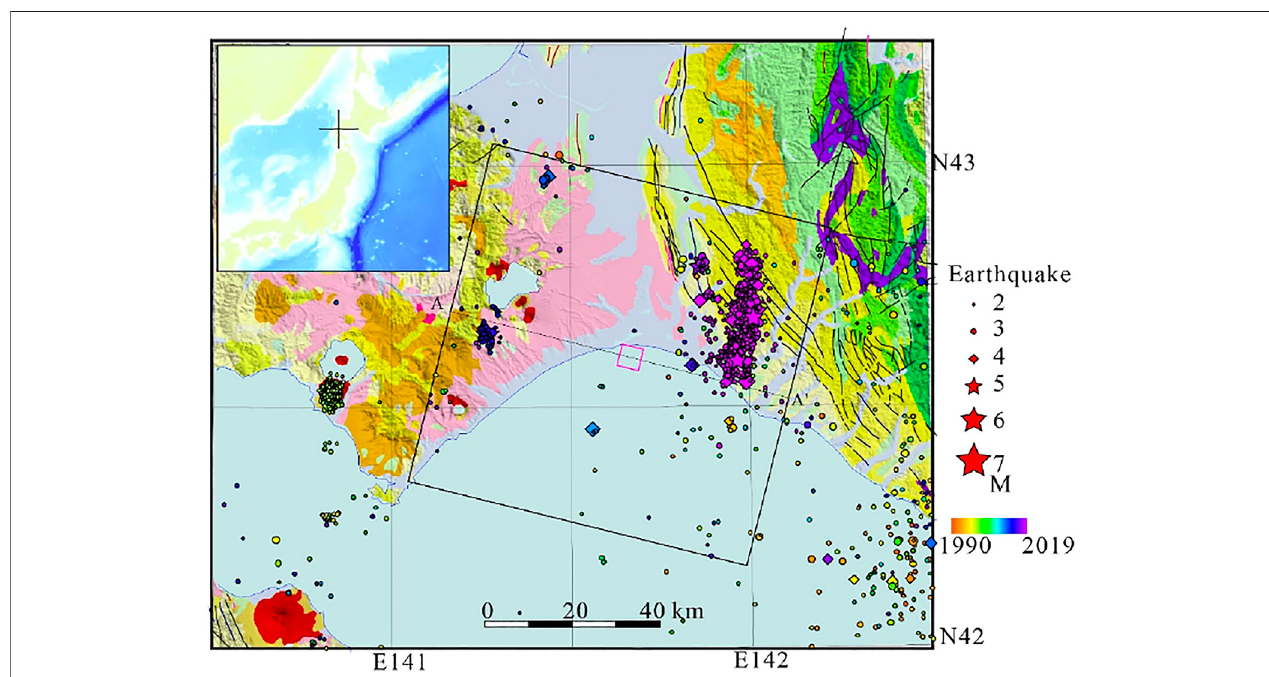
FIGURE1| MapviewoftheTomakomaicarbon captureandstorage(CCS)-CO 2 injectionsiteandearthquakeepicentersobservedfrom1990through2019(from the Japan Meteorological Agency (JMA) earthquake catalog) overlaid on geological map (from (Japan, 1995)). The pink square indicates the injection site. Line A-A ′ masks the pro fi le in Figure 2